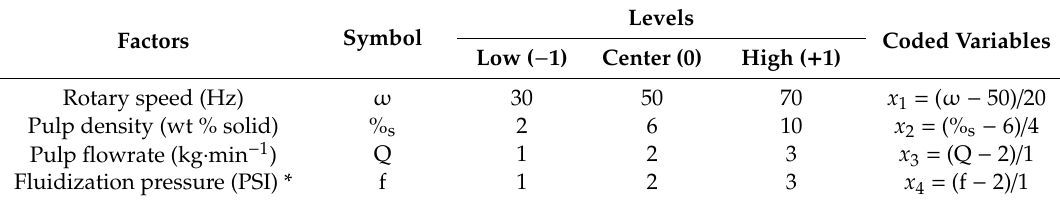
Table 2. Independent factors and corresponding levels for the experimental designs.